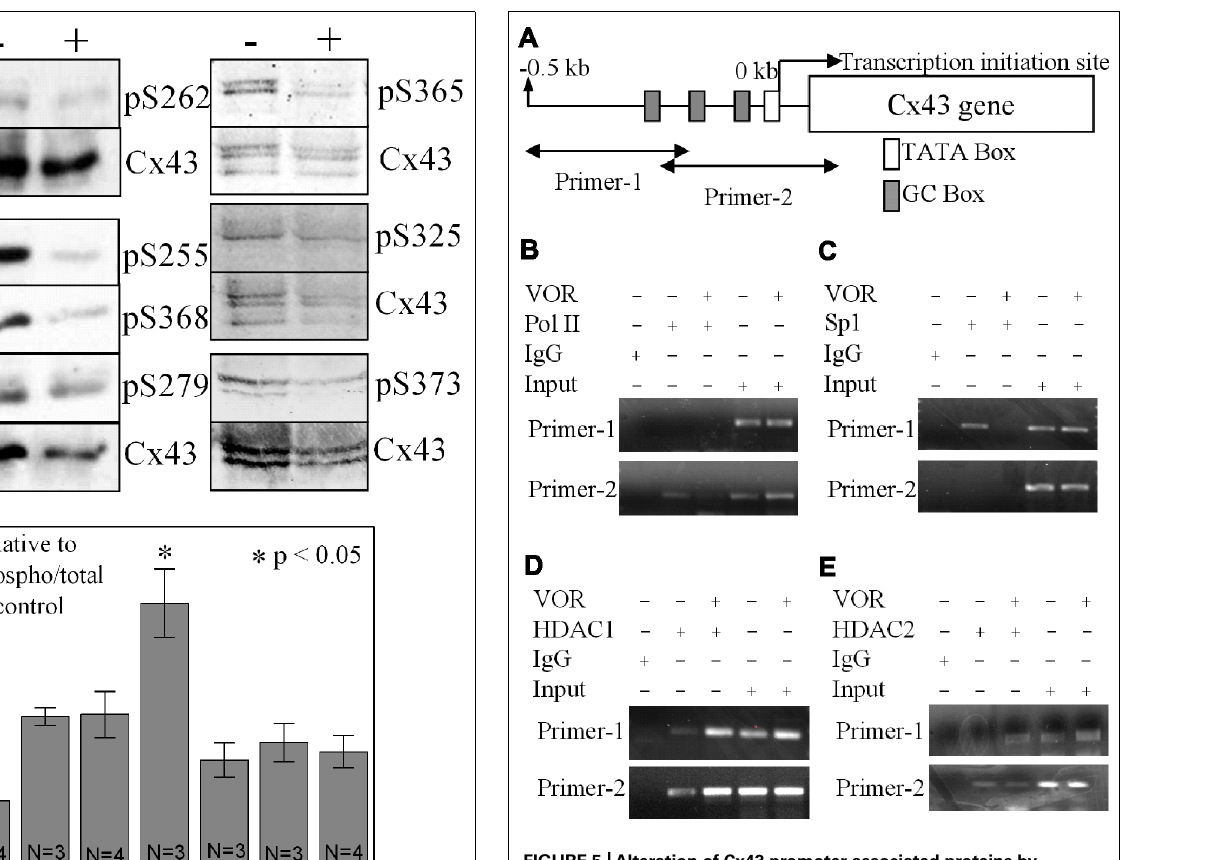
FIGURE 5 |Alteration of Cx43 promoter associated proteins by vorinostat. (A) Illustration of the Cx43 promoter region up to − 0.5 kb from the Cx43 gene ( Gja1 ) transcription start site of Cx43 withTATA and GC boxes indicated.Two primer sets were designed from − 511 to − 206 and − 225 to + 65 bp of the Cx43 promoter region. (B,C) Chromatin immunoprecipitation assays illustrate the reduced binding of RNA polymerase II (RNA Pol II) and specific protein 1 (Sp1) to the promoter region of Cx43 after overnight exposure to 2 μ MVOR. (D,E) A chromatin immunoprecipitation assay was performed with rabbit IgG and rabbit anti-HDAC1 or anti-HDAC2 antibodies to assess the binding of HDAC1 (D) and HDAC2 (E) to the promoter region of the Cx43 gene ( Gja1 ). Overnight treatment with 2 μ MVOR enhanced the association of HDAC1 and HDAC2 to the Gja1